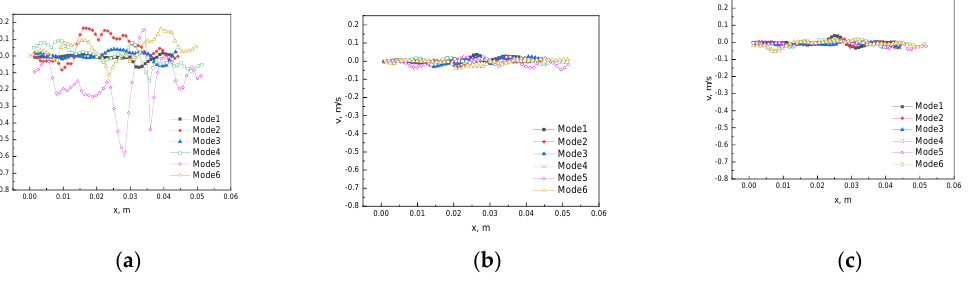
Figure 7. Vertical component of velocity at 1 mm below liquid surface in three physical forms of hydraulic jump (casting speed 0.8 m/min). ( a ) CHJ; ( b ) HJT; ( c ) SLL.